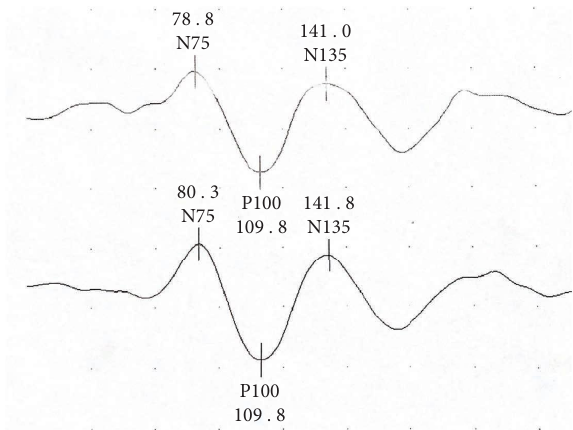
Figure 2: A waveform sample from control group. VEP amplitude, N75, N135, and P100 latencies for the right and left eyes were measured. Te upper waveform was obtained from the right eye and the lower waveform was obtained from the left eye. (Latencies are given in milliseconds (ms) and amplitudes in microvolts ( μ V). Between two points in the vertical direction represents 5 μ V. Peak- to-peak amplitude of the P wave are 7.85 μ V on the upper wave and 9.28 μ V on the lower wave, respectively).